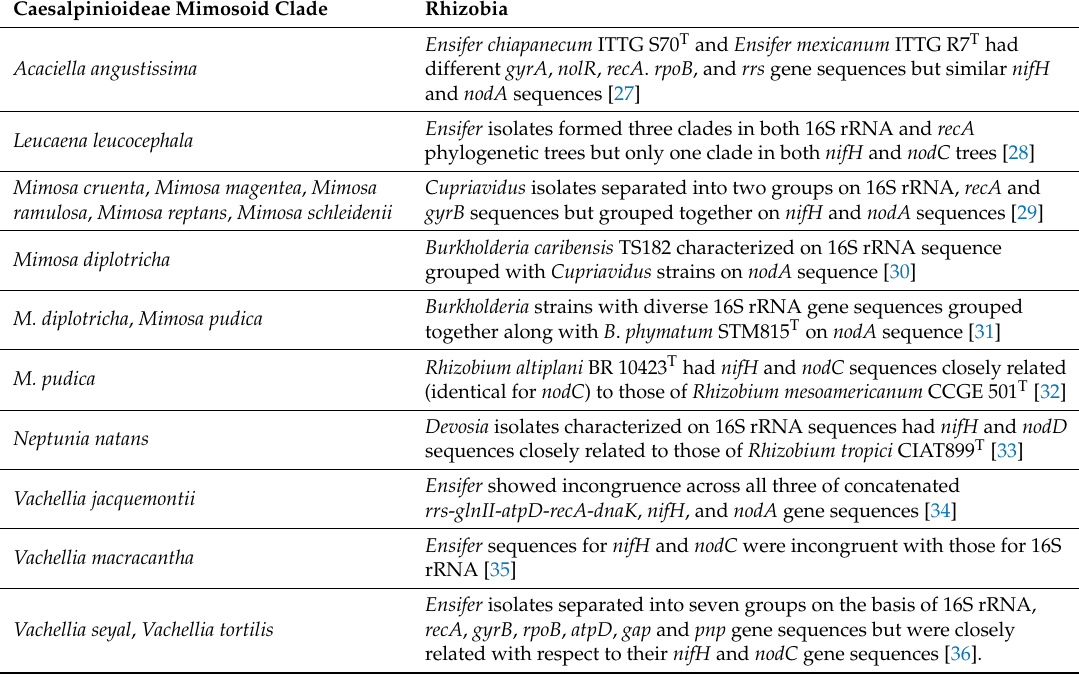
Table 1. Reported cases of phylogenetic incongruence between core and symbiosis genes for rhizobia associated with legumes in the sub-family Caesalpinioideae. All species have indeterminate nodules. Caesalpinioideae Mimosoid